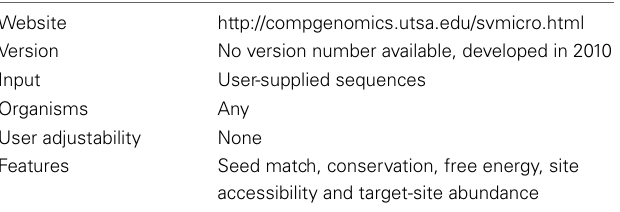
Table 8 | Profile of SVMicrO. Table 9 | Profile of PITA.